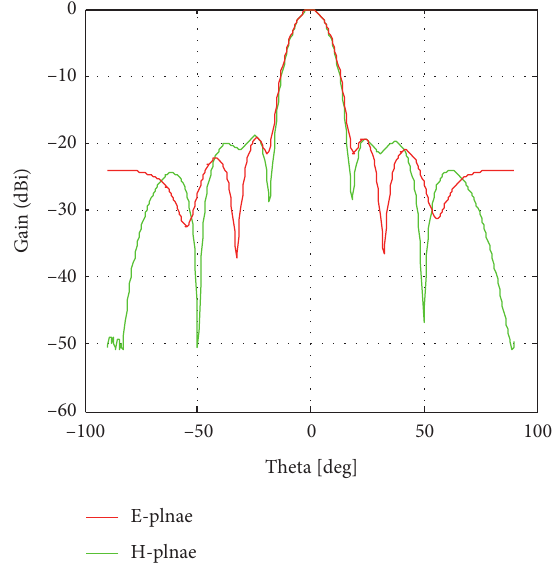
Figure 6: Normalized radiation pattern of proposed 34 elements thinned array antenna in E-plane and H-plane in MATLAB.